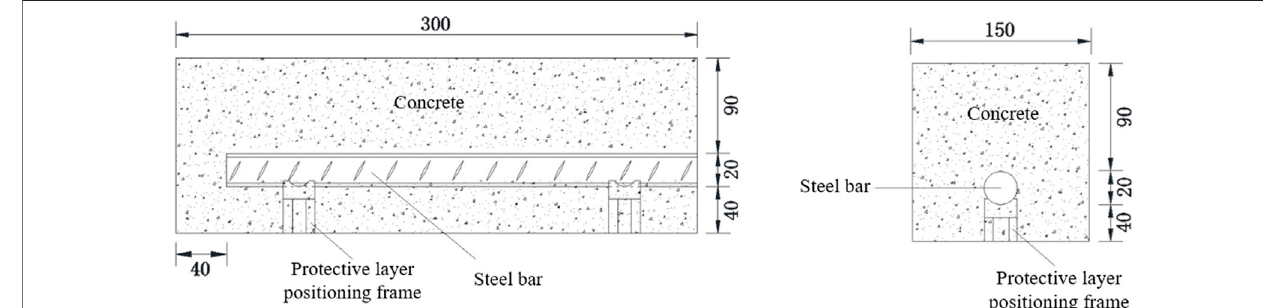
FIGURE 2 | Layout of epoxy-coated steel bar.